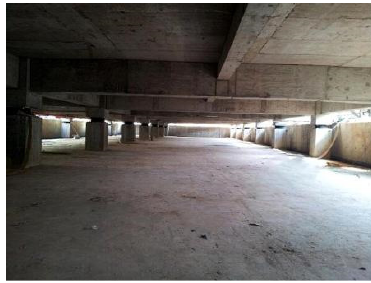
Figure 4. Isolation overhaul layer.